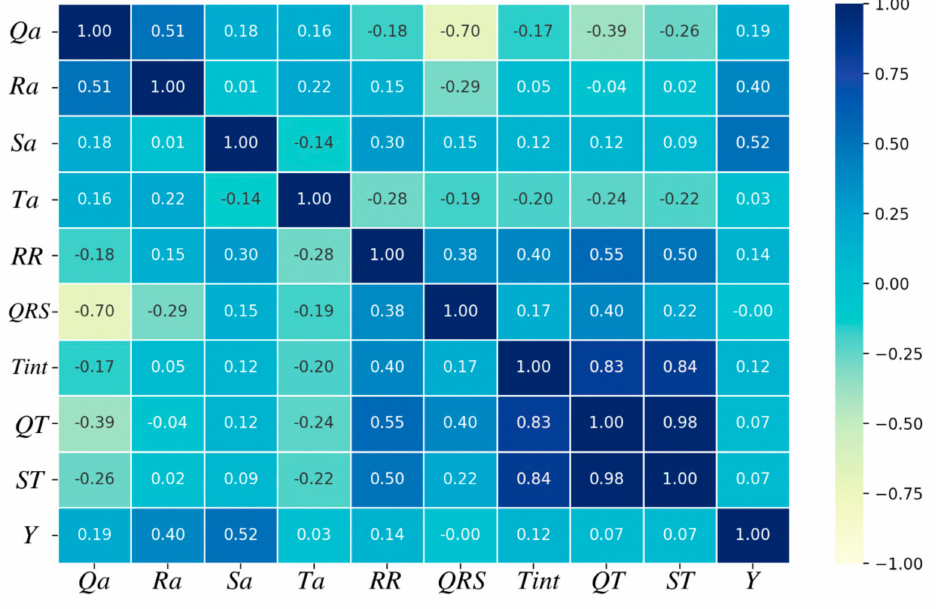
Figure 4. Pearson correlation coefficients between ECG signal